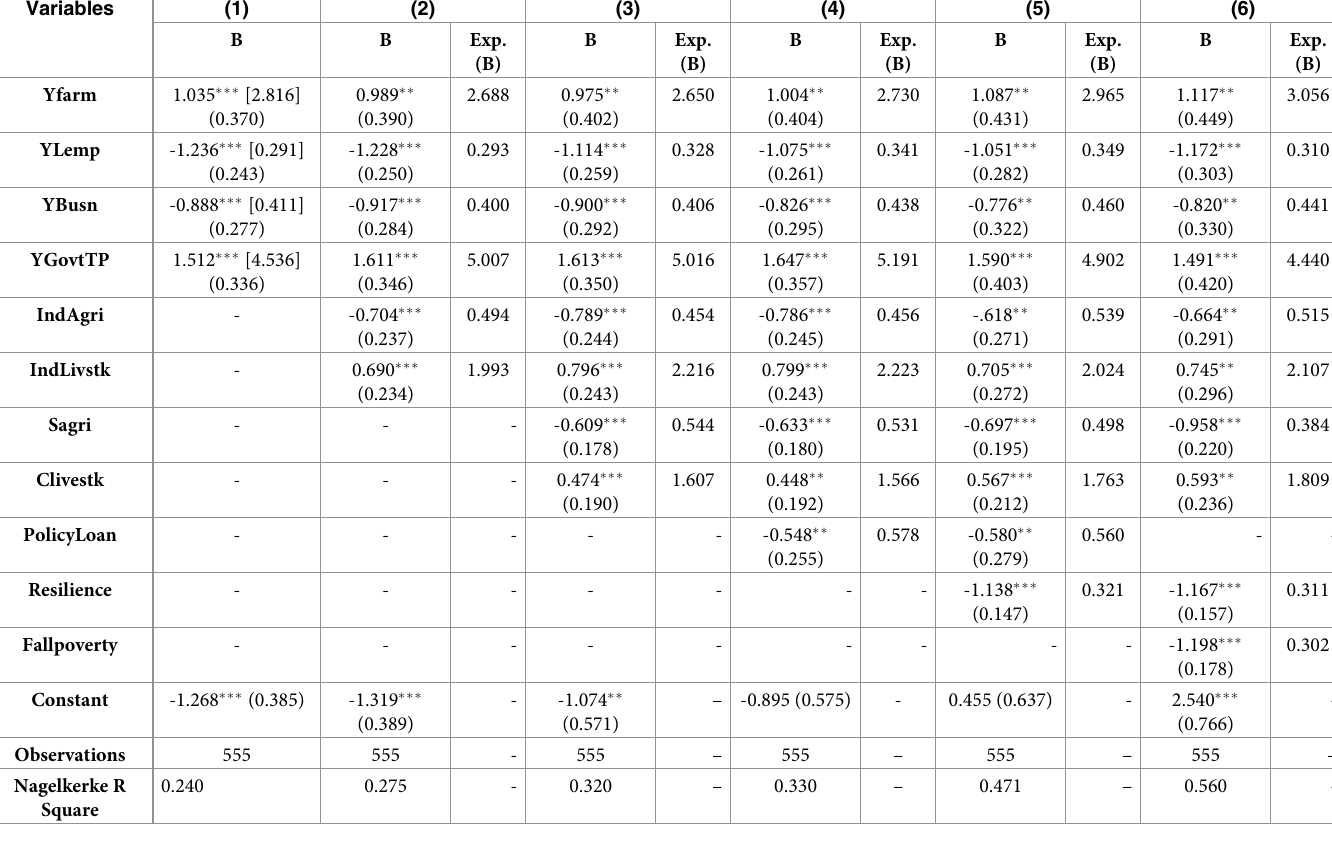
Table 7. Binary logistic regression